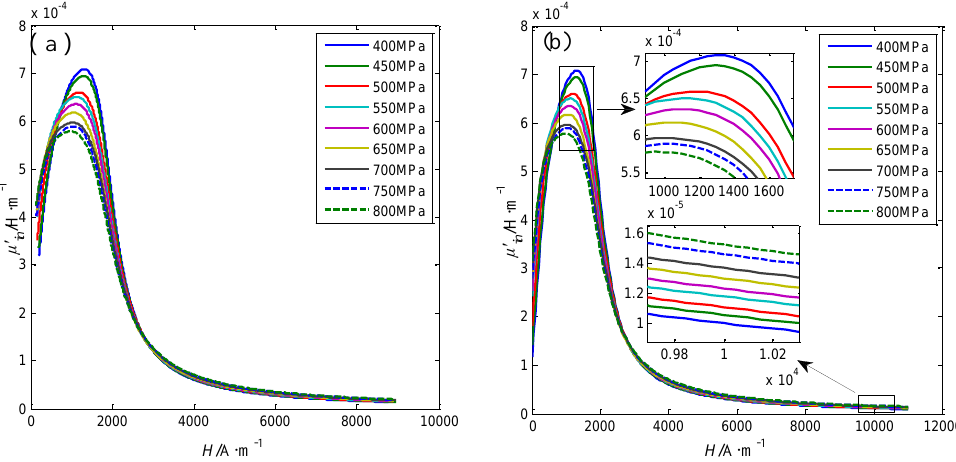
Figure 15. The differential permeability curves before ( a ) and after ( b ) the extrapolation for No.1 Φ5 steel wire under different axial stresses.